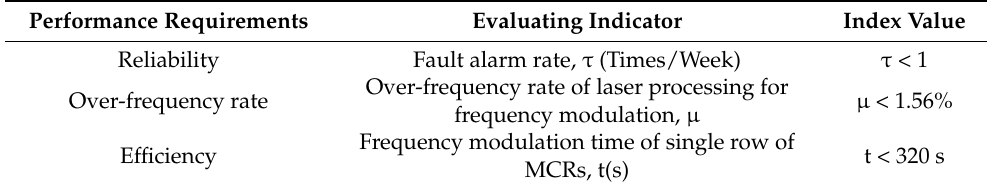
Table 1. Performance requirements and indexes of laser processing control system for MCR frequency